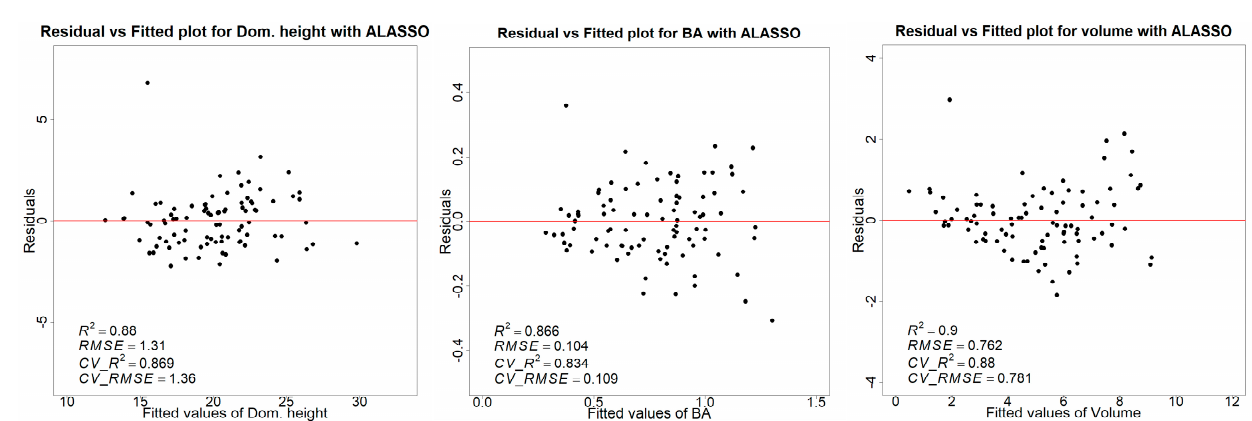
Figure 8. Each panel shows the residual vs. fitted plot for volume with ALASSO models. R 2 and RMSE are the model accuracy before cross-validation, and CV_R 2 and CV RMSE show the model accuracy result of nine-fold cross-validation.